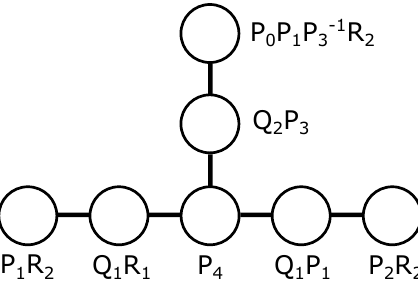
Figure 39. The Kähler parameters of the fibers which form the affine E 6 Dynkin